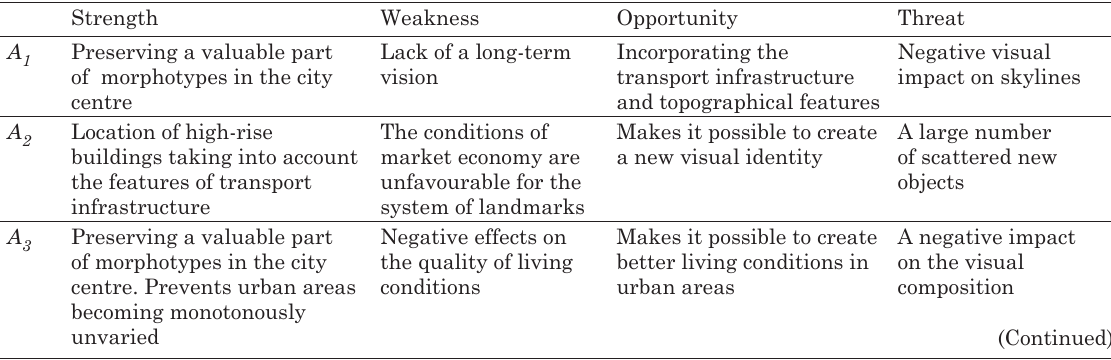
table 2. The selection criteria defining the location models for high-rise buildings in the urban structure Strength Weakness